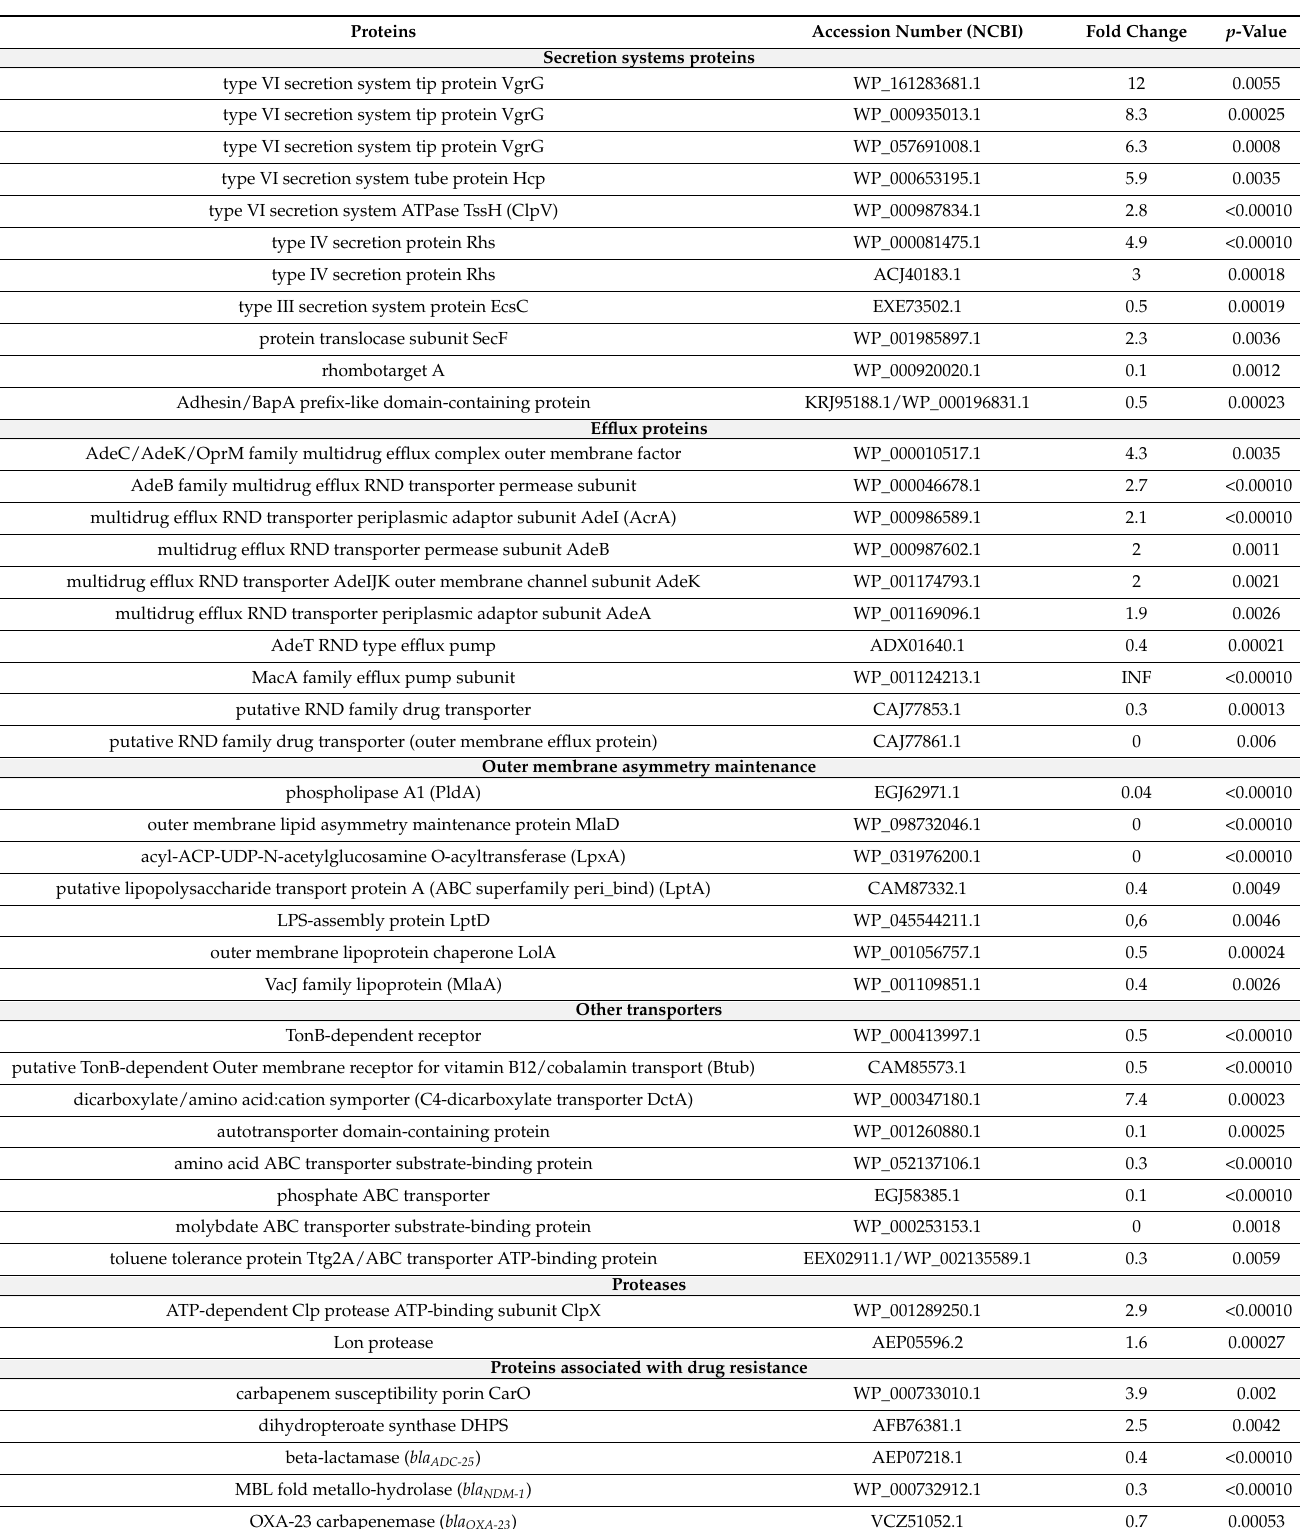
Table 5. Selected groups of proteins differentially expressed in Ab-S and Ab-D. Fold changes were calculated with Ab-S as the reference category. Fold change value 0 means that protein was detected in Ab-S, but not in Ab-D. Proteins Accession Number (NCBI) Fold Change p